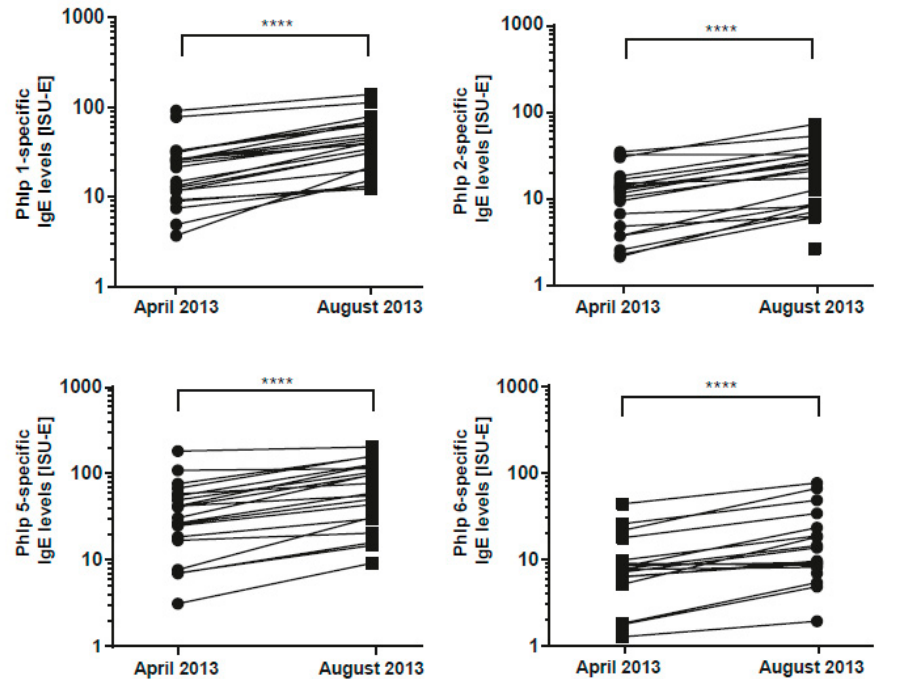
Figure 5. Grass pollen allergen-specific IgE levels before and after exposure to grass pollen. Graphs show IgE levels specific to the 4 major grass pollen allergens (Phl p 1, Phl p 2, Phl p 5, and Phl p 6) in grass pollen-allergic patients ( n = 21) measured before (April 2013) and after (August 2013) exposure to seasonal grass pollen. Differences between IgE levels were calculated via the Wilcoxon matched-pairs signed rank test, and p values are indicated (**** p < 0.0001).